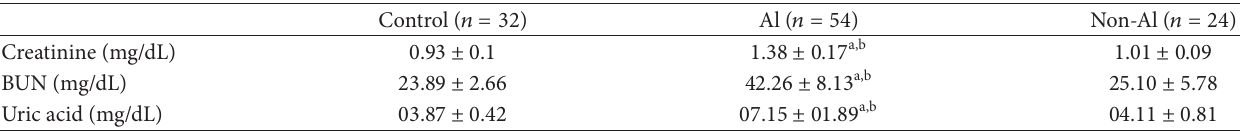
Table 2: Serum creatinine, BUN, and uric acid.